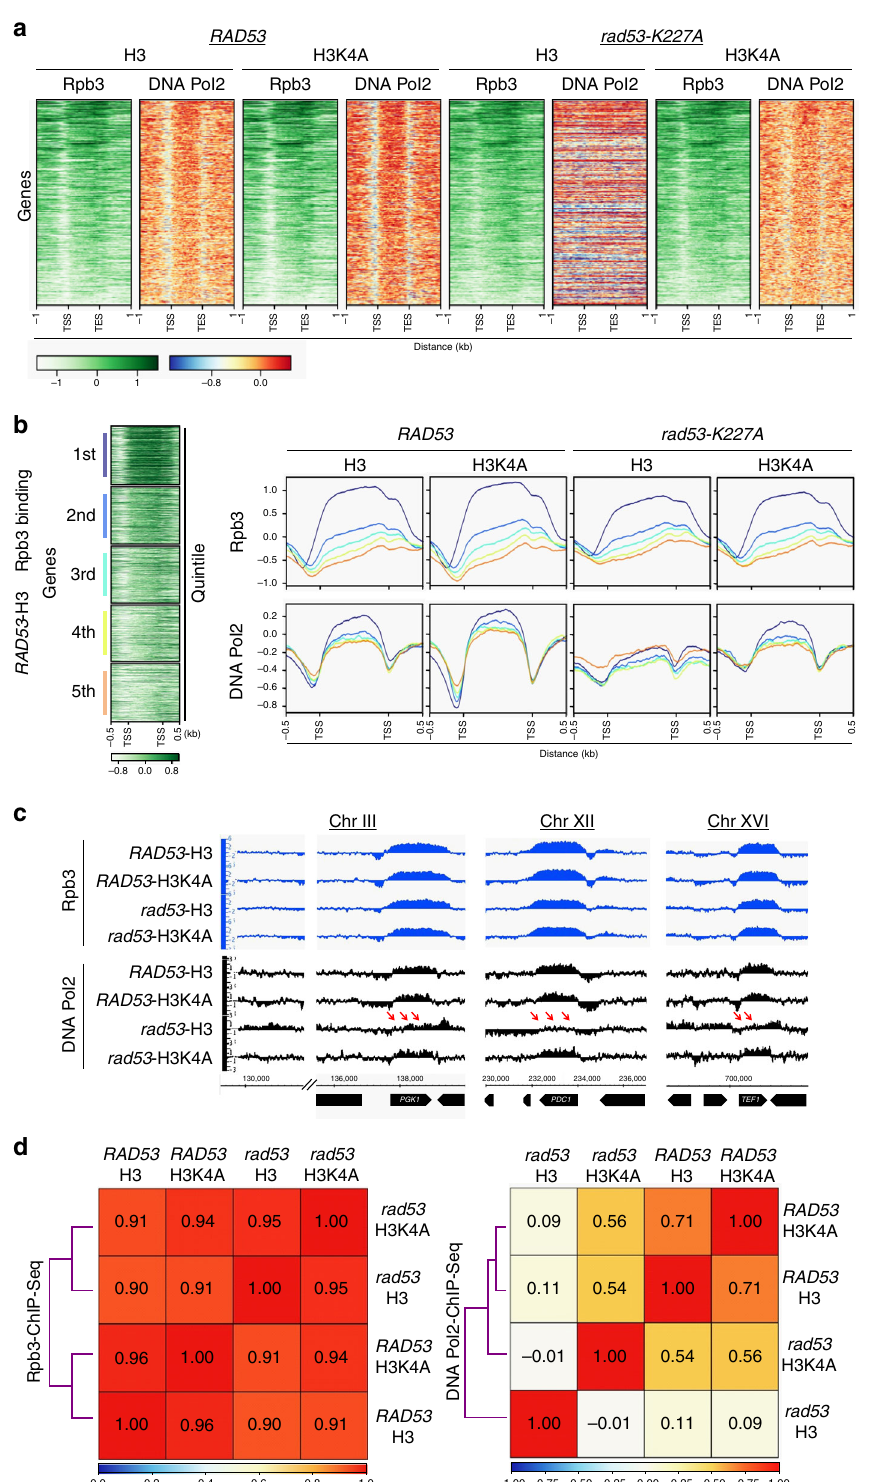
Fig. 2 Loss of H3K4 methylation restores DNA Pol2 binding in rad53 mutant under replication stress. a Heatmaps of ChIP-seq signals for Rpb3 and DNA Pol2 from RAD53- H3, RAD53- H3K4A, rad53-K227A -H3 and rad53-K227A -H3K4A cells after 25 mM HU treatment for 2 h. TSS: transcription start site; TES: transcription end site. b Anchor plots of Rpb3 and DNA Pol2 ChIP signals sorted into quintiles, according to the expression ef fi ciency (see Methods). Pro fi les in indicated colors represent gene clusters from the fi rst to fi fth quintile. Average signal strength of each cluster represented in log 2 scale. c Representative ChIP-seq tracks of Rpb3 and DNA Pol2 on selected highly transcribed genes in WT and mutant cells. rad53 refers to the rad53-K227A mutant. The signals represent normalized sequence read density (log 2 scale) on loci along the indicated regions of respective chromosomes (see Methods). Red arrows mark the DNA Pol2 signals that were lower in rad53 -H3 cells, indicating a lack of binding with regions undergoing transcriptional progression. d Spearman ’ s rank correlation coef fi cient of genome-wide Rpb3 (right-panel) and DNA Pol2 (left-panel) ChIP-seq signals in indicated